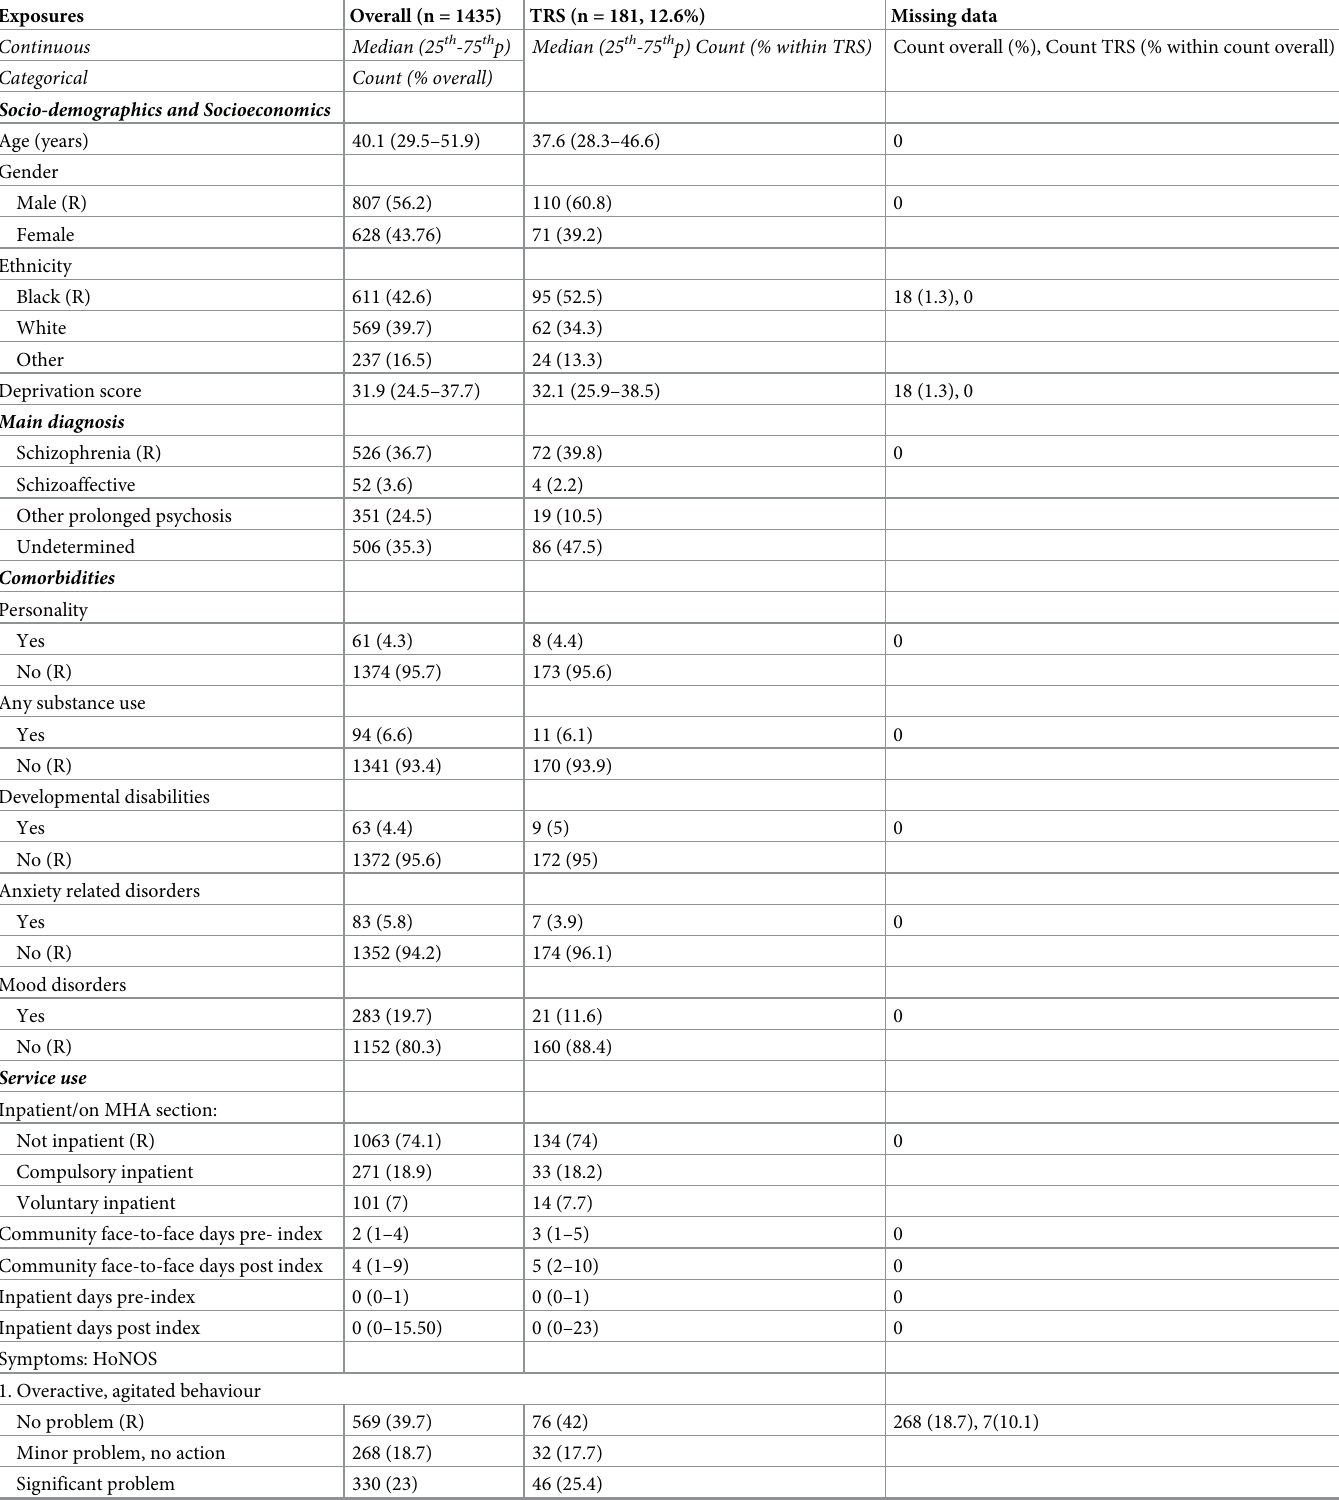
Table 1. Descriptive statistics of treatment resistant schizophrenia